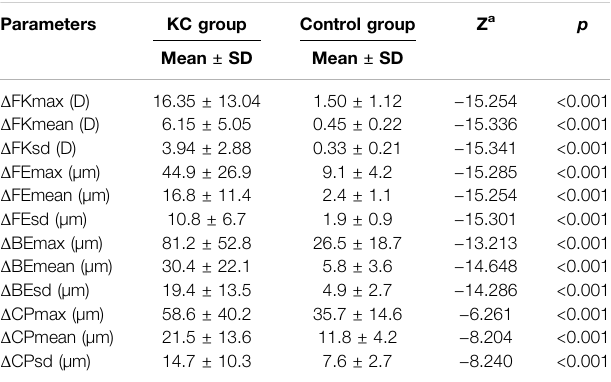
TABLE 2 | Differences in bilateral differential topographic characteristics between groups.